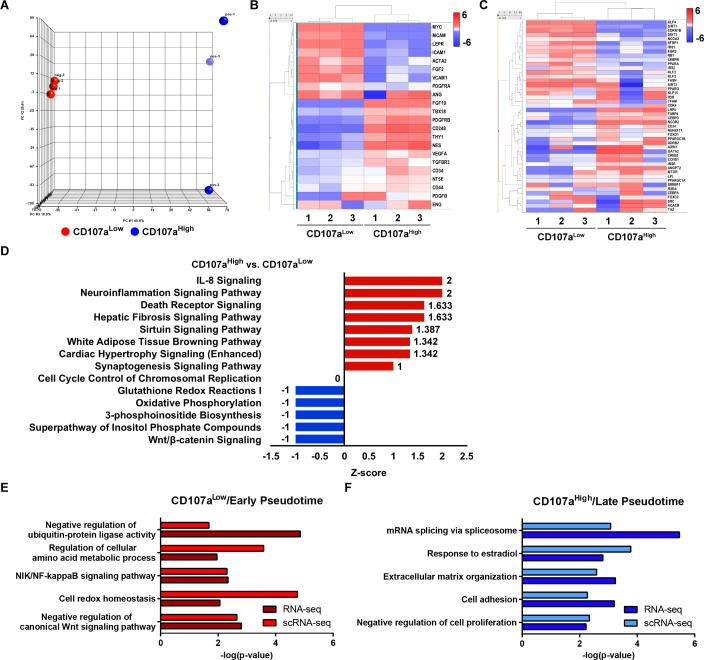
Bulk RNA sequencing among uncultured CD107alow and CD107ahigh mesenchymal cells and relationship to putative adipose cell hierarchy.(A–F) Total RNA sequencing comparison of CD107alowCD31-CD45- and CD107ahighCD31-CD45- mesenchymal cells from a single human subcutaneous WAT sample. (A) Principal component analysis among CD107alowCD31-CD45- and CD107ahighCD31-CD45- cells. (B) Heat map demonstrating mRNA expression levels of stemness-related markers and perivascular cell markers among CD107alowCD31-CD45- and CD107ahighCD31-CD45- mesenchymal cells. (C) Expression of adipogenic gene markers among CD107alowCD31-CD45- and CD107ahighCD31-CD45- mesenchymal cells, shown in heat map. (D) Ingenuity pathway analysis (IPA) identified representative pathways that were upregulated (Z-score >0; red color) or downregulated (Z-score <0; blue color) in CD107ahighCD31-CD45- compared with CD107alowCD31-CD45- mesenchymal cells. (E,F) Comparison of CD107ahigh/low bulk sequencing data to human SVF single-cell sequencing data (see again Figure 3O–Q). (E) Pathways enriched in both CD107alow bulk RNA-seq and early pseudotime genes derived from scRNA-seq. (F) Pathways enriched in both CD107ahigh bulk RNA-seq and late pseudotime genes derived from scRNA-seq.